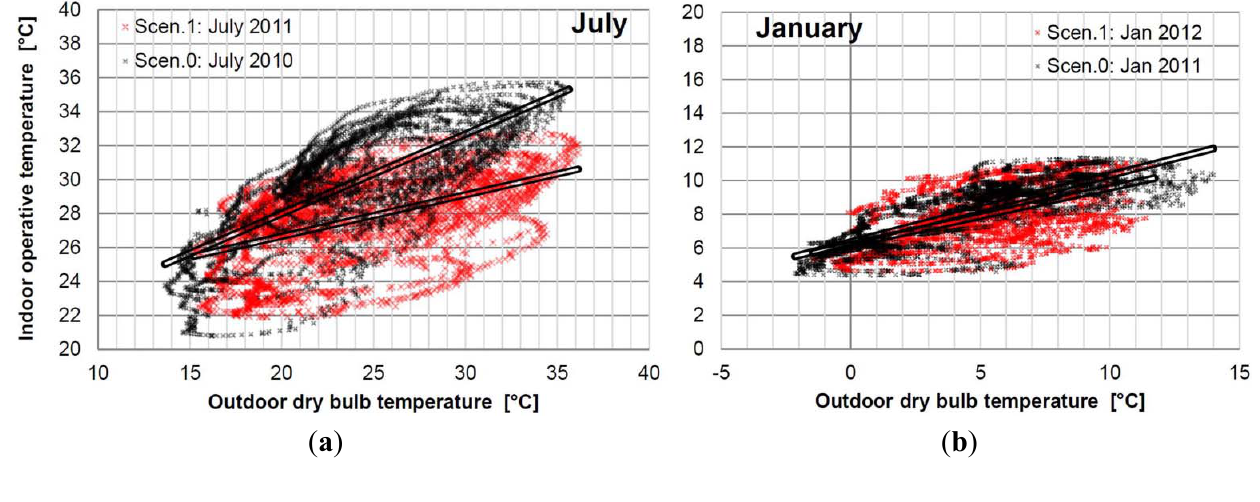
Figure 8. Monthly assessment of the indoor operative temperature versus outdoor dry bulb temperature of the location in ( a ) July and ( b )